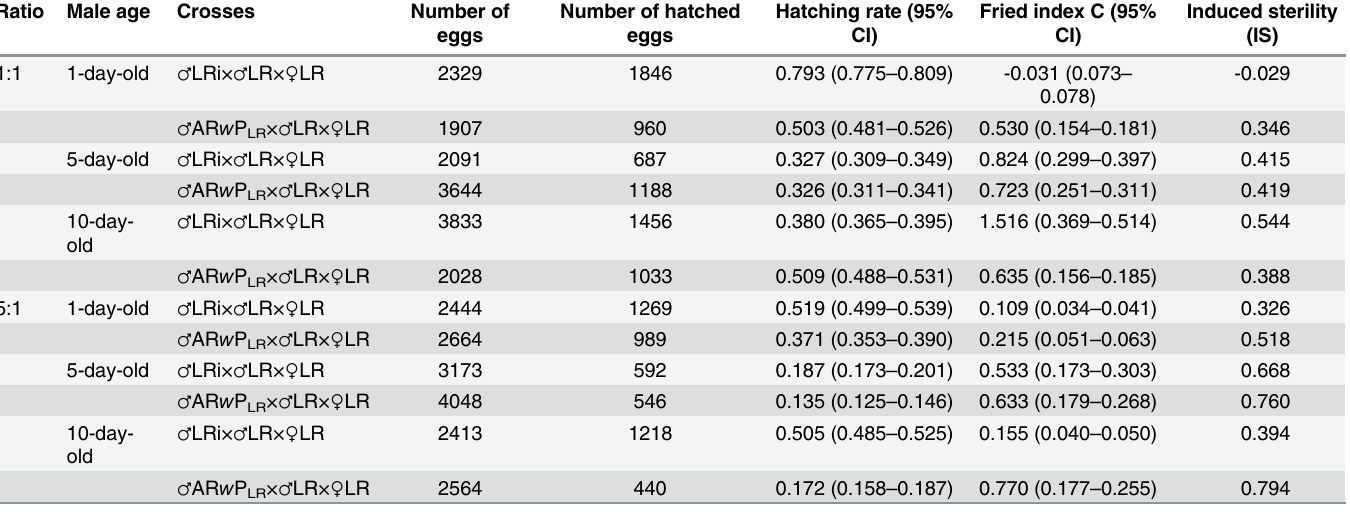
Table 3. Mating competitiveness of irradiated (LRi) and incompatible (AR w P LR ) Ae . albopictus males in cages containing either a 1:1 or a 5:1 ratio with respect to wild-type males (LR).